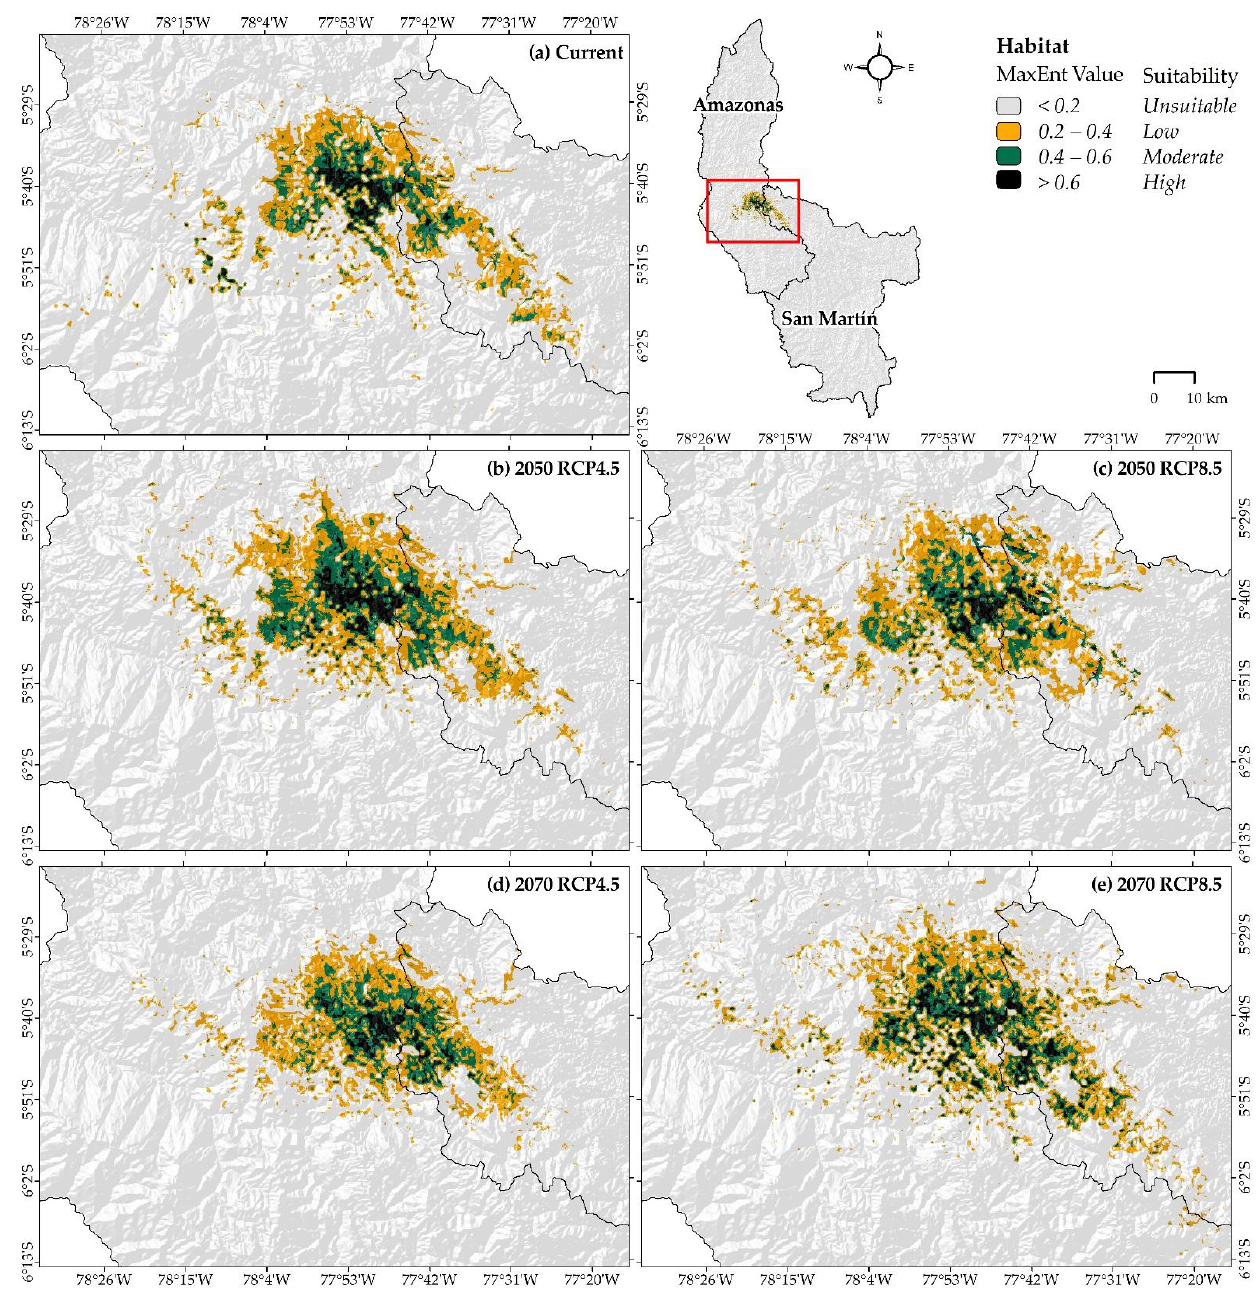
Figure 6. Potential current distribution of X. loweryi and climate change scenarios in Amazonas and San Martin, NW Peru.